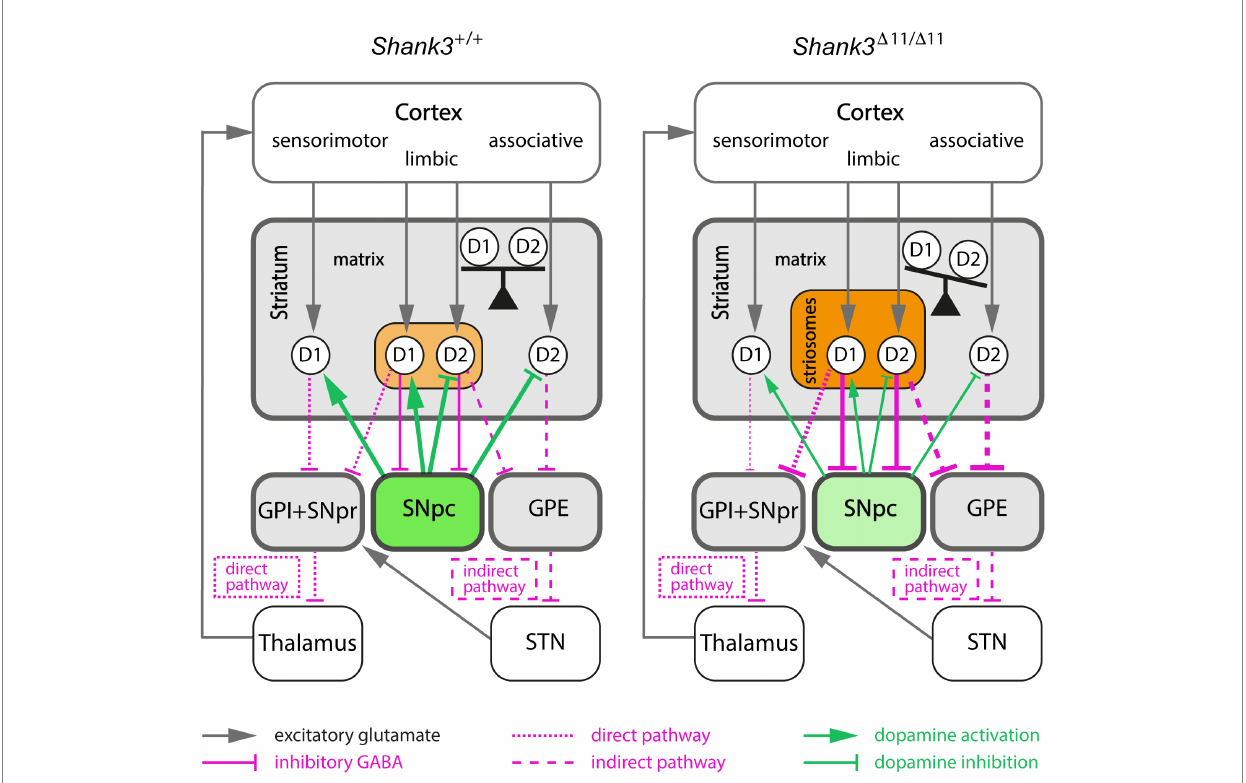
FIGURE 4 Proposed model linking increased activity in the striosomal pathway and imbalance between the direct and indirect pathways in the Shank3 Δ 11/ Δ 11 mice. The modifications of connection strength (line thickness) induced by striosomal compartment alterations in Shank3 Δ 11/ Δ 11 mice are only represented between the striatum and its output target areas (colored boxes). Increased activity of the striosomal pathway in Shank3 Δ 11/ Δ 11 mice, due to both larger size and increased GAD65 activity of the striosomal compartment (light/dark orange) enhances GABAergic inhibition of the dopamine-producing neurons of SNpc (green). This inhibition of the SNpc neurons (light green) results in an imbalance between the direct and indirect pathways by decreasing both the activation of D1-MSN (D1) and the inhibition of D2-MSN (D2). GPI, internal globus pallidus; GPE, external globus pallidus; SNpr, substantia nigra pars reticulata; SNpc, substantia nigra pars compacta; STN, subthalamic